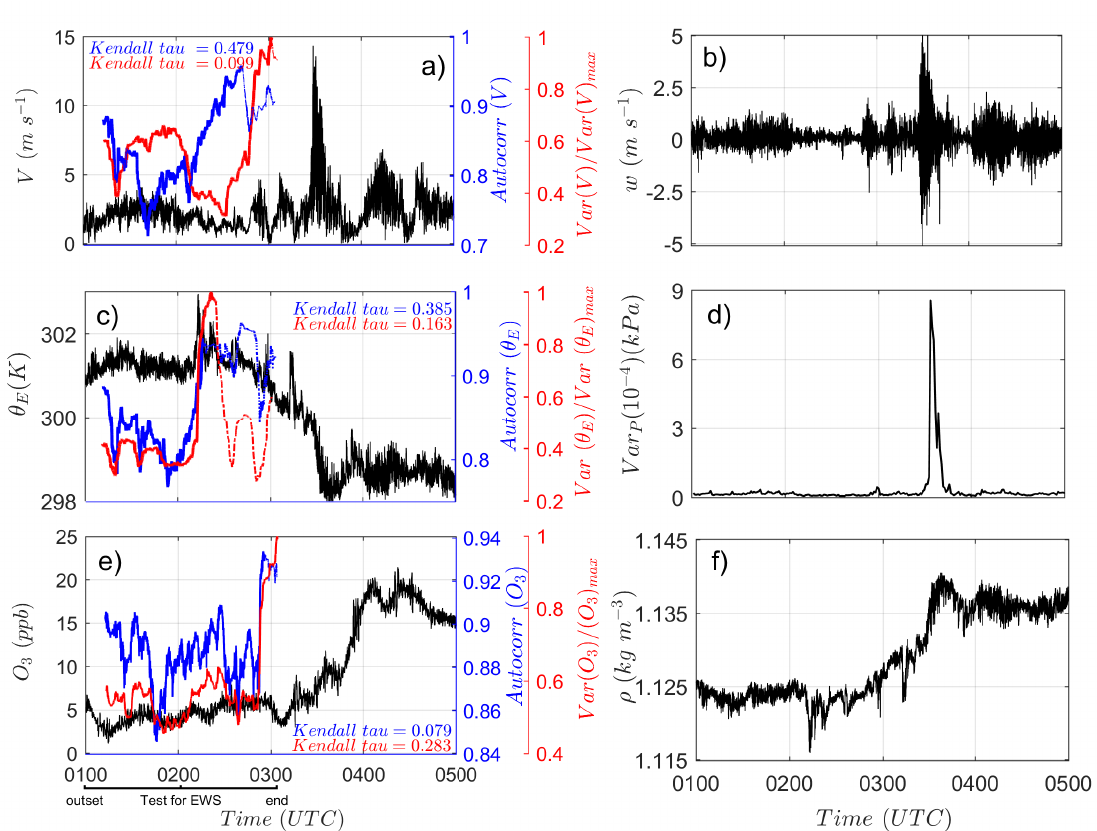
Figure 2. Turbulent time series of: ( a ) horizontal wind velocity ( V ), ( b ) vertical wind velocity ( w ), ( c ) equivalent potential temperature ( θ E ), ( d ) Pressure variance of the air ( Var P ), ( e ) ozone mixing ratio (O 3 ), and ( f ) air density ( ρ ). The blue and red lines are the autocorrelation function and variance, respectively. These time series were recorded on 13 April 2014. At 0330 UTC there is an occurrence of extreme